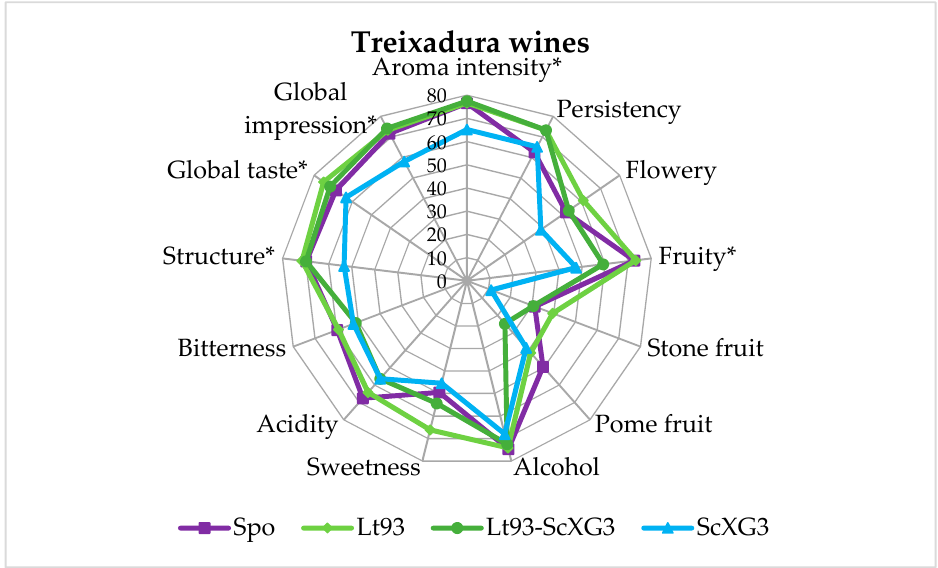
Figure 7. Sensory profile of Treixadura wines obtained with different yeast strains. * Descriptor with significant differences among wines at p < 0.05.